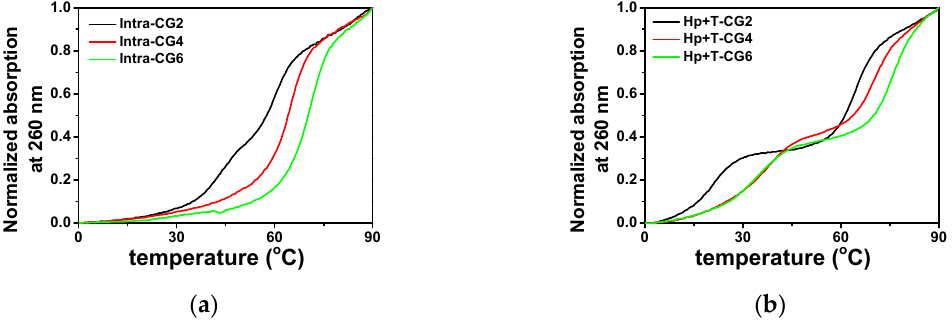
Figure 3. Normalized UV melting curves at 260 nm of ( a ) intramolecular triplexes and ( b ) intermolecular